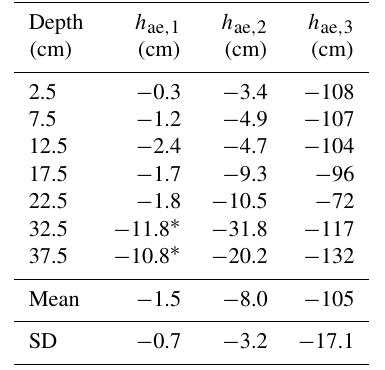
Table 3. Air-entry pressures of the three pore systems of the effec- tive SHP for all sampling depths (left column) and arithmetic means to delimit the individual pore